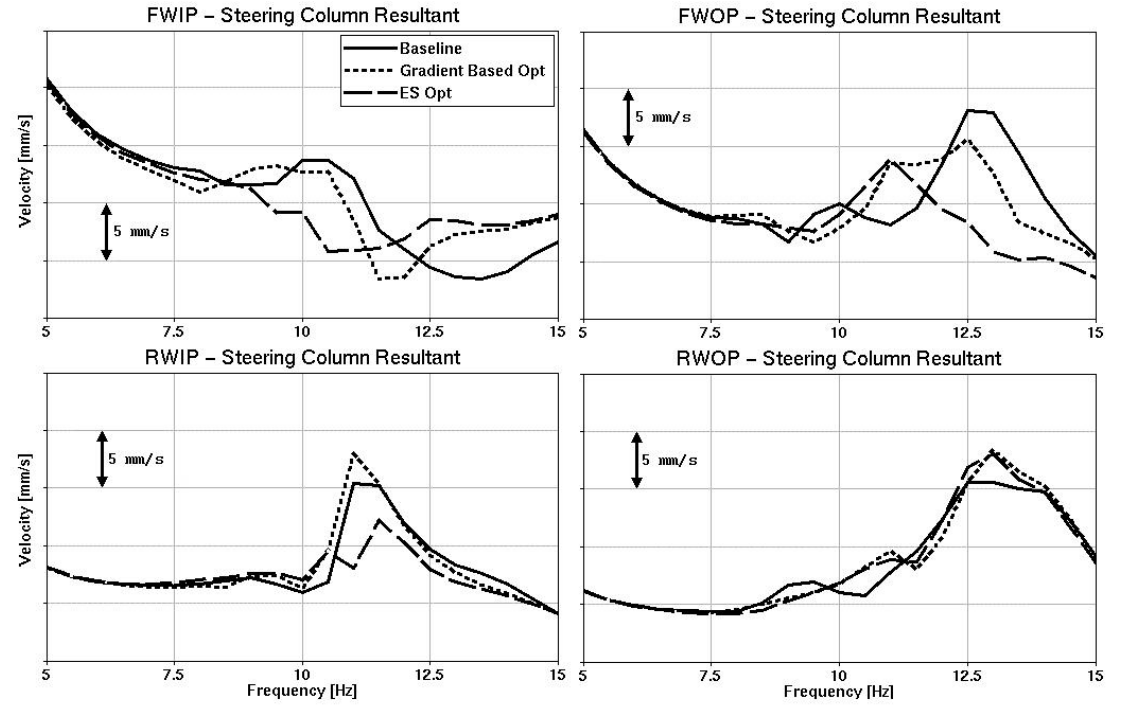
Fig. 13. Road shake response of the full-vehicle system at the steering column. The four loadcases were: front and rear wheels in-phase (FWIP/RWIP) and out-of-phase